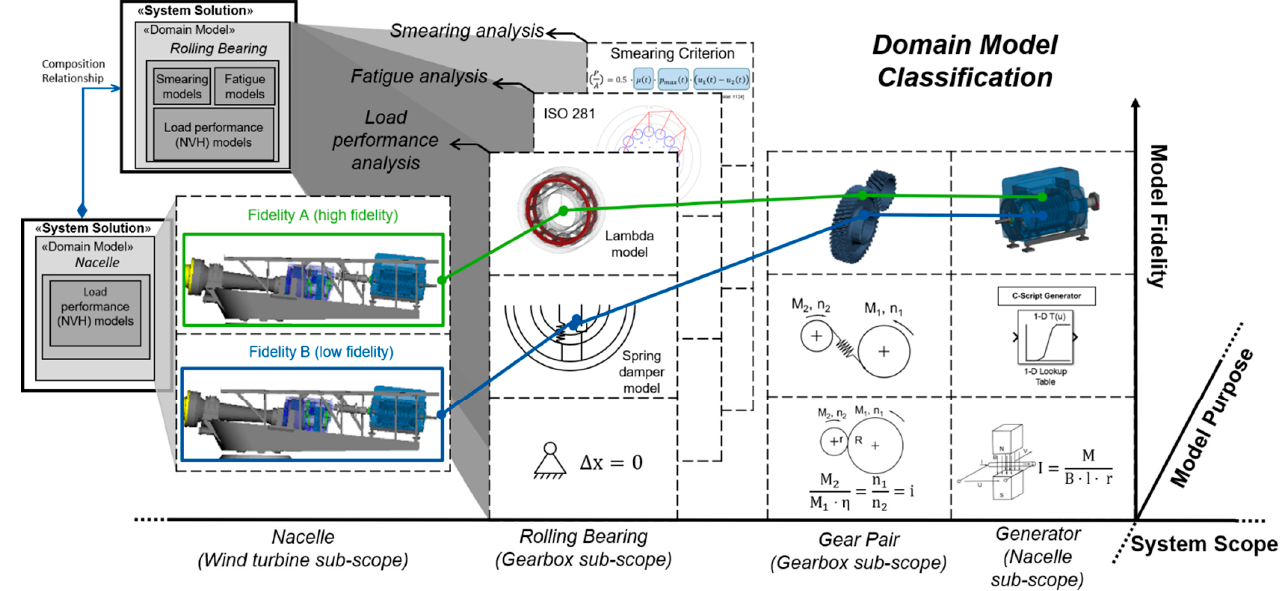
Figure 4. The classification of domain models based on system scope, model purpose, and model fidelity .